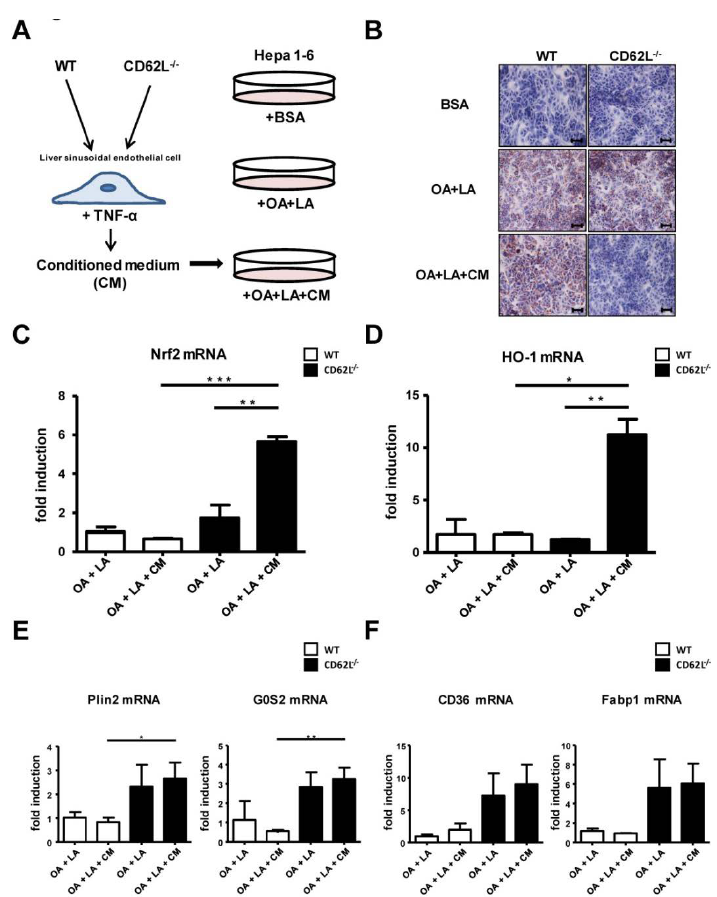
Figure 5. Activation of the anti-oxidative stress response and increased fat turnover in Hepa1-6 cells after stimulation with medium of activated liver sinusoidal endothelial cells (LSEC) from CD62L − / − mice. ( A ) Isolated primary LSEC of WT and CD62L − / − mice were activated by stimulation with bovine serum albumin (BSA) (control) or TNF- α for 24 h. Hepa1-6 cells were stimulated with linoleic acid-oleic acid-albumin (OA + LA) and additionally with conditioned medium (CM) (OA + LA + CM) of TNF- α -stimulated primary LSEC of WT and CD62L − / − mice for 24 h. ( B ) Representative Oil Red O-stained tissue culture slides are depicted showing the progressive decrease of Oil Red O-staining in CD62L − / − mice after stimulation with OA + LA + CM (400 × ). ( C ) Nrf2, ( D ) HO-1, ( E ) Plin2, G0S2, ( F ) CD36 and Fabp1 mRNA expression was analysed in the stimulated Hepa1-6 cells via RT-qPCR. For quantification values are expressed as fold induction over the mean values obtained for OA + LA treated Hepa1-6 cells (* p < 0.05, ** p < 0.01, and *** p <